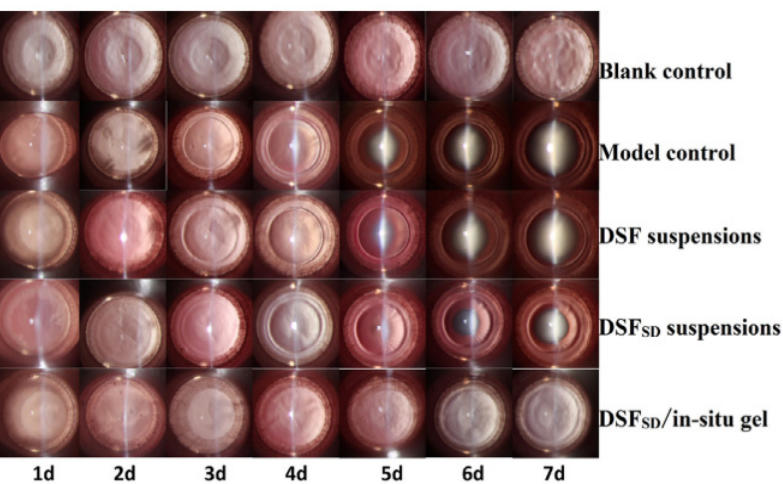
Figure 4. The anti-cataract effect of the blank group, model group, DSF suspensions group, DSF SD suspensions group, and DSF SD /in situ gel group were evaluated throughout the 7 days of administration. (Blank control): the lenses were clear; (Model control): the opacity was observed and developed cataracts; (DSF suspension): the cataract was developed faster on day 4 and day 5 compared to the model group; (DSF SD suspension): the cataract was developed but not as severe as the DSF suspension group; (DSF SD /in situ gel): the lenses were clear, and no opacity was detected throughout 7 days [39].